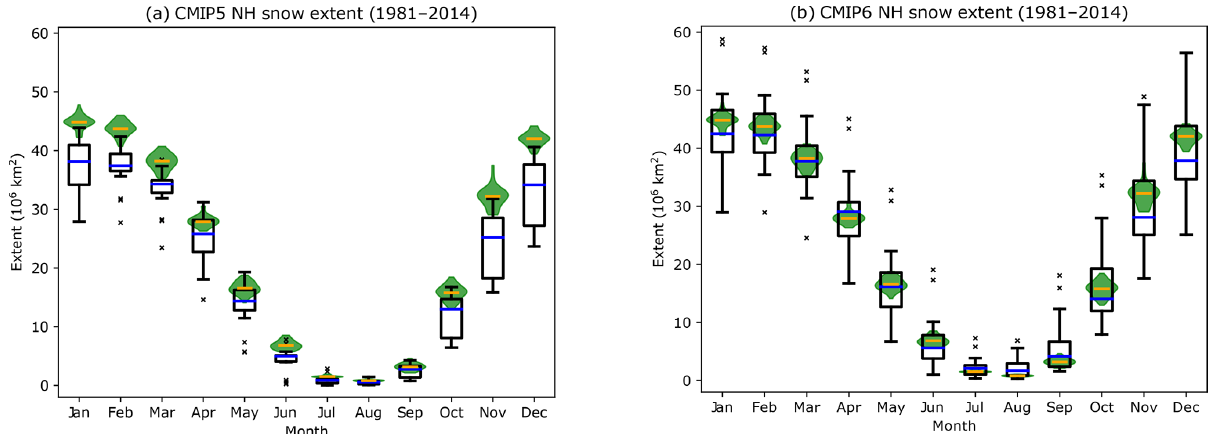
Figure 3. Simulated CMIP5 (a) and CMIP6 (b) monthly mean 1981–2014 NH snow extent. The green violins (yellow bar: median year) represent the observed interannual distribution. The boxes and whiskers represent the individual models’ (first ensemble member) 1981–2014 average from the CMIP5–CMIP6 multi-model ensembles (red bar: median